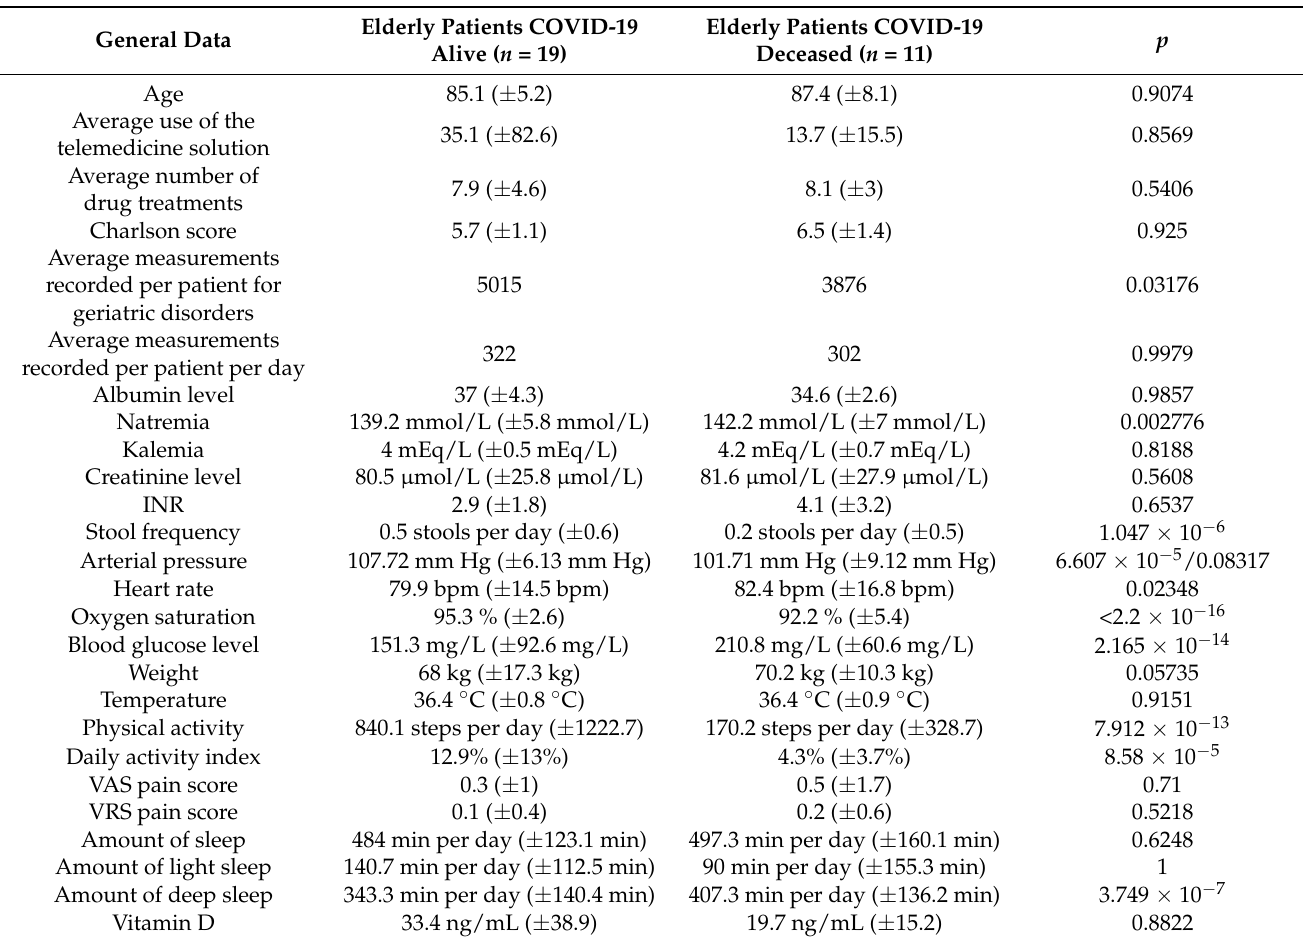
Table 4. Elderly patients COVID-19 alive VS elderly patients COVID-19